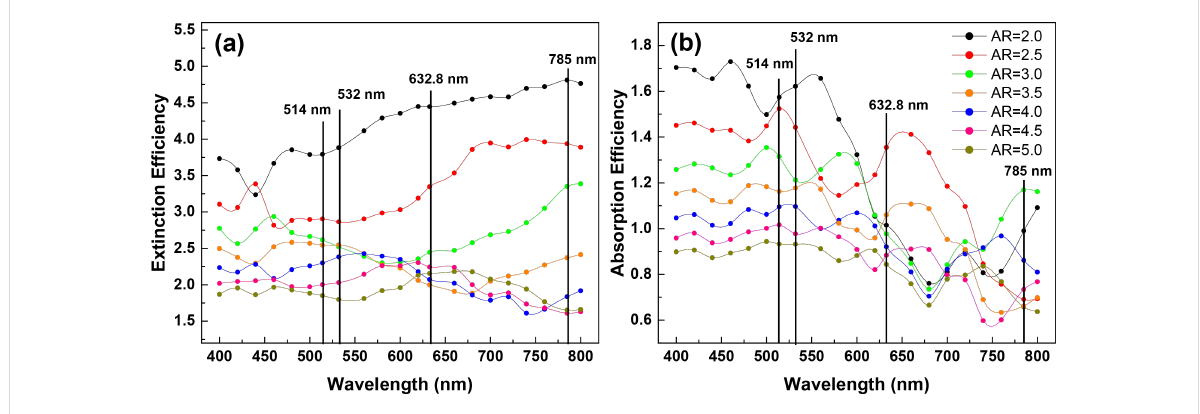
Figure 7: (a) Extinction efficiency spectra of S42 AgNR 2D hexagonal array with AR ranging from 2.0 to 5.0; (b) absorption efficiency spectra of S42 AgNR array with AR ranging from 2.0 to 5.0. The incident polarization is parallel to the y -direction. Vertical solid lines indicate the excitation laser wavelengths used in Figure 6.